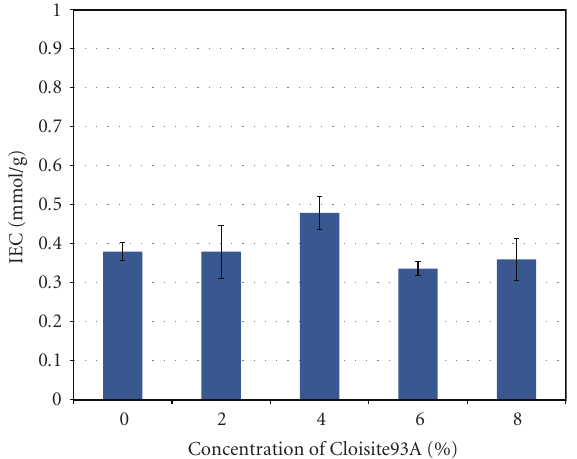
Figure 4: IEC values of sulfonated PVA membranes with varying concentrations of Cloisite